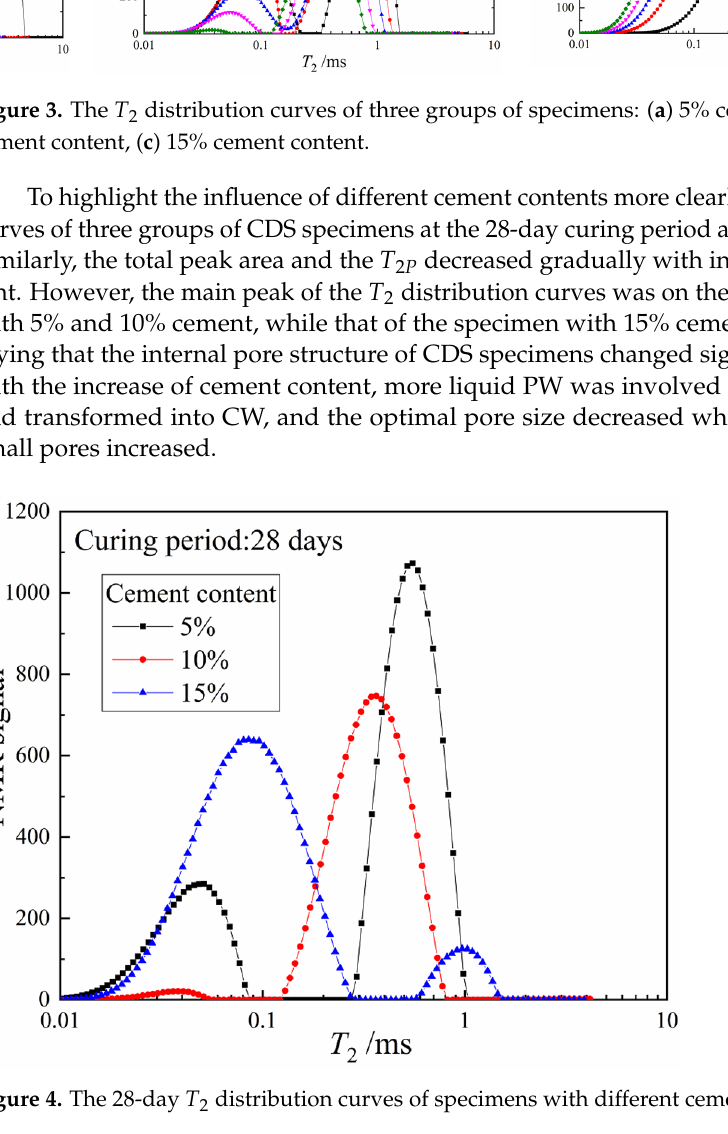
Figure 4. The 28-day T 2 distribution curves of specimens with different cement content.